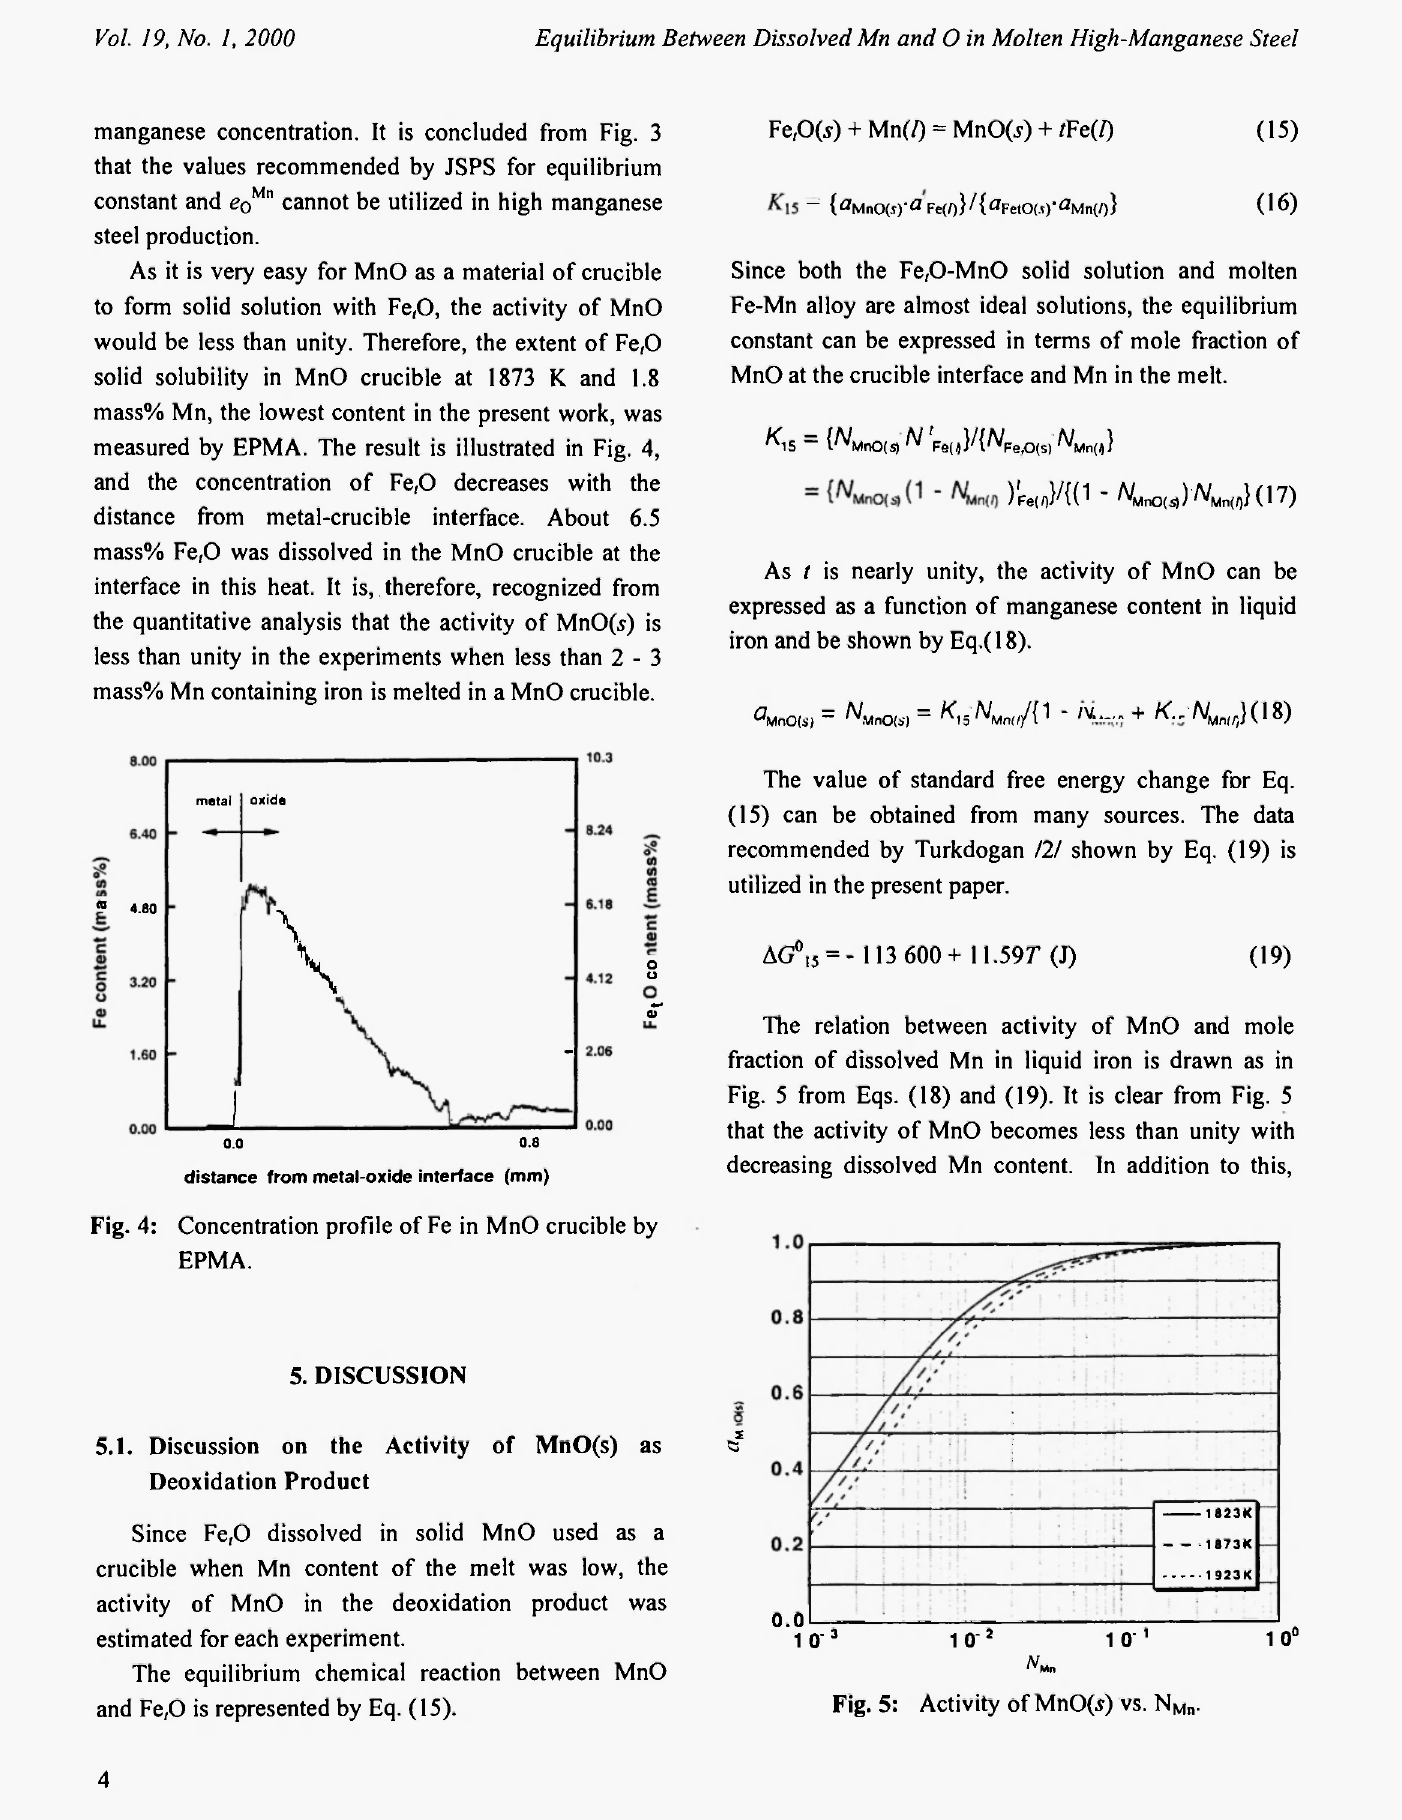
Fig. 5: Activity of MnO(s) vs. N Mn